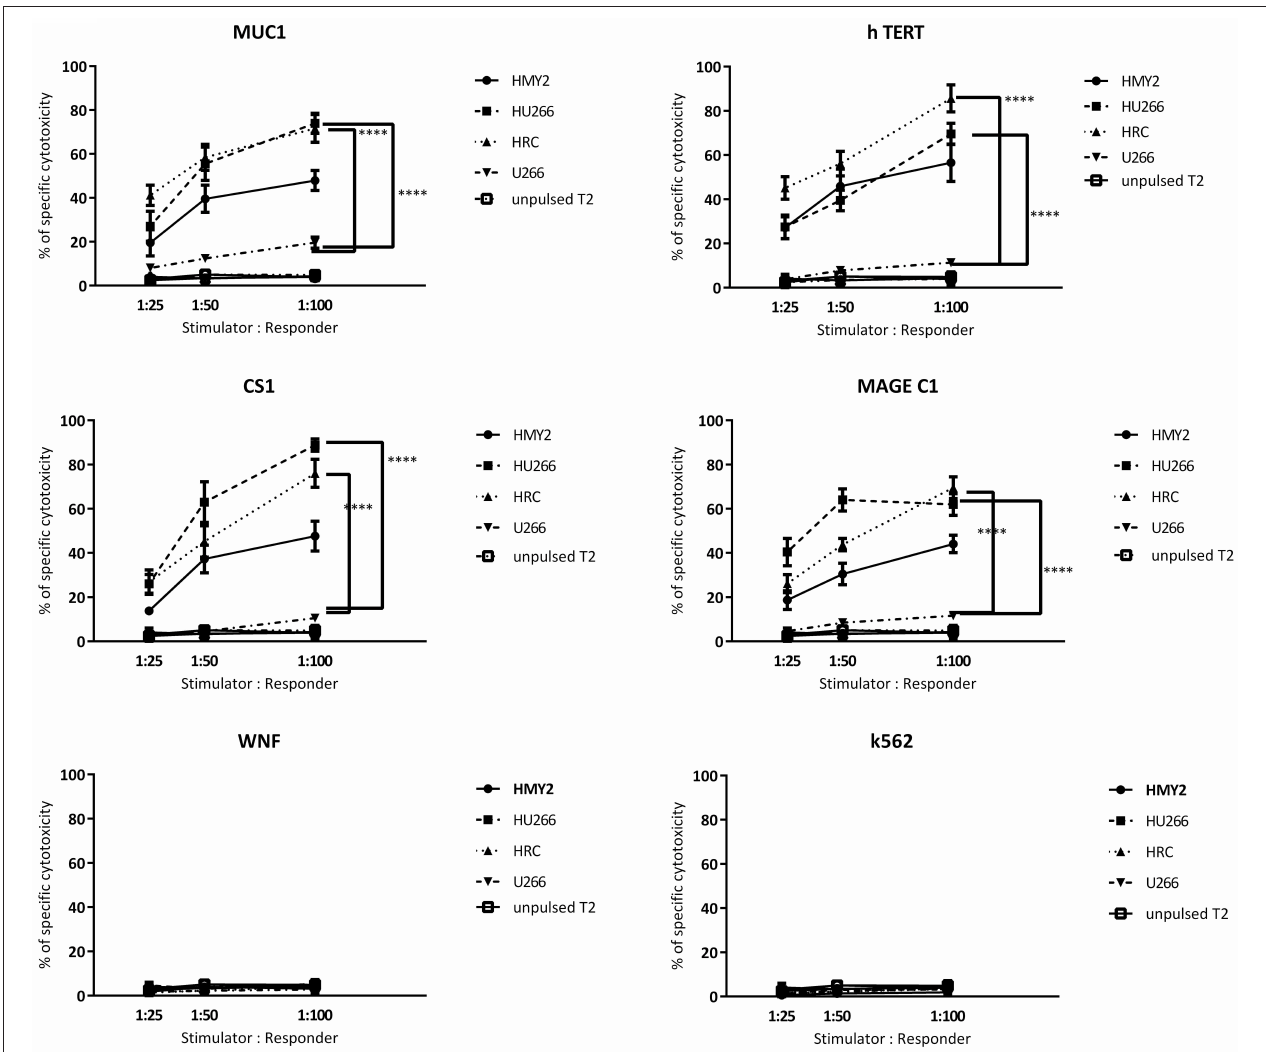
FIGURE 6 | Europium release cytotoxicity assays. Individual plots show the percentages of specific lysis (Y axis) of peptide pulsed T2 cells, by T cells from cultures stimulated by the hybrid cell lines (HRC and HU266), HMy2 cells, and the parent myeloma cell line U266, from five different HLA-A2 + MM patients. The stimulator to responder ratios are presented on the X axis. The peptides used to pulse T2 cells are the same as those used in ELISPOT assays shown in Figures 3 , 4 . K562 were used as controls to assess NK activity. Data are presented as mean ± SEM of % specific lysis induced, and statistically significant differences are indicated as asterisks (**** p ≤